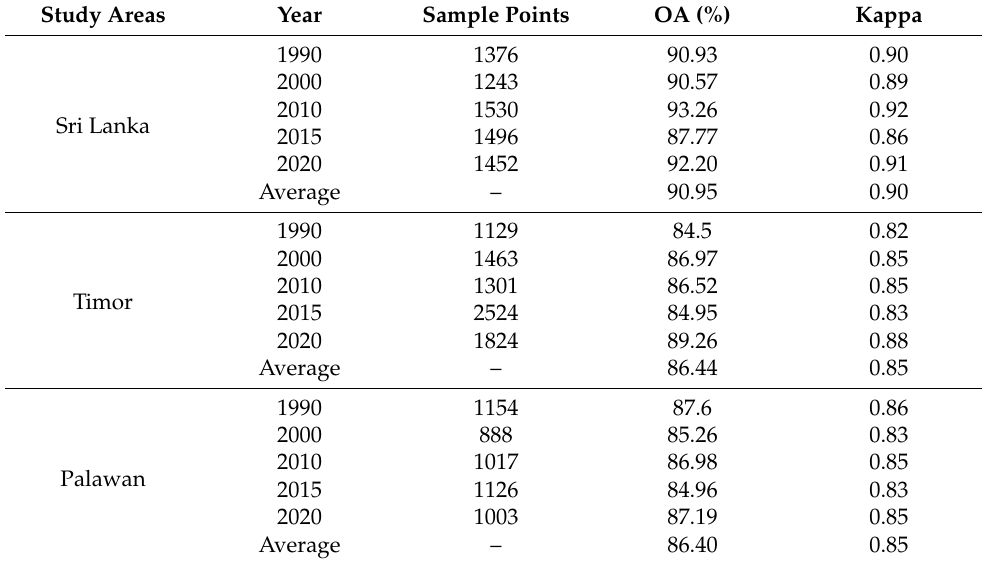
Table 2. Accuracy assessment for land cover